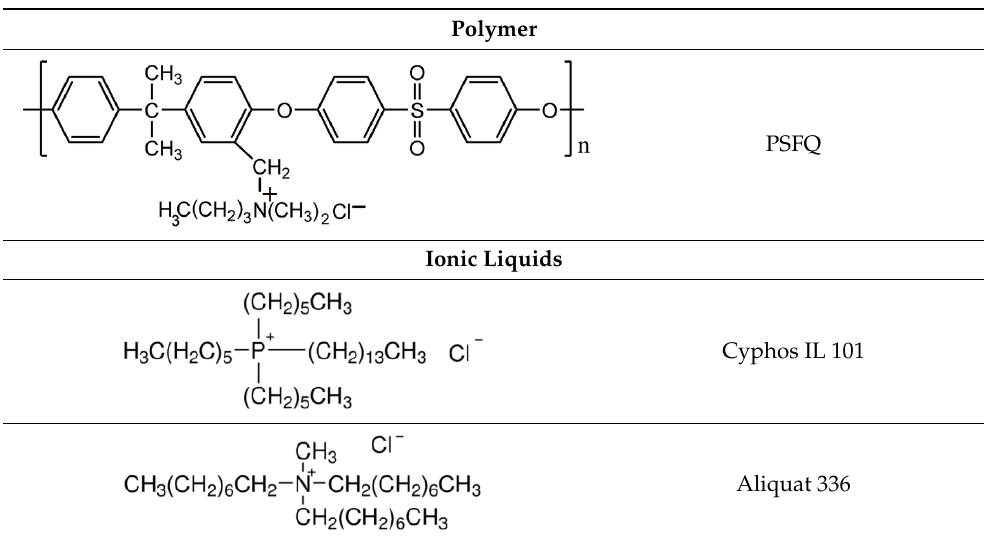
Table 2. Chemical structures of the monomer unit of polysulfone with quaternary ammonium groups (PSFQ) and used ionic liquids (trihexyl(tetradecyl)phosphonium chloride — Cyphos IL 101 and methyltrialkylammonium chloride — Aliquat 336).